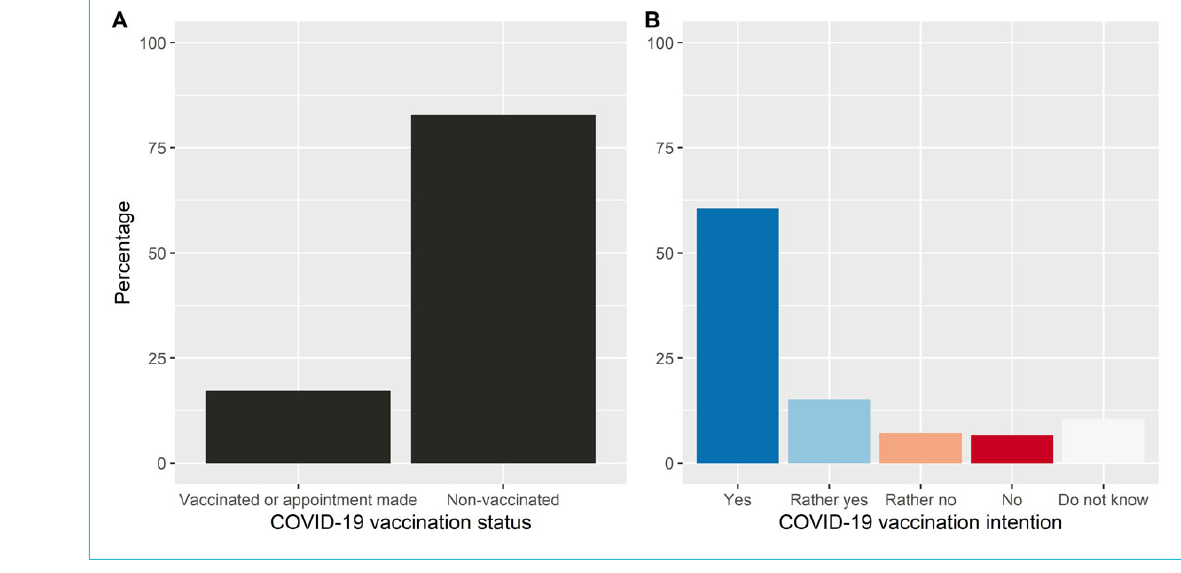
Figure 1: A. Proportion of participants vaccinated / with appointment for vaccination versus participants not vaccinated against COVID-19. B. Intention to get vaccinated against COVID-19; "yes" combines those willing to get vaccinated and those already vaccinated or who have an